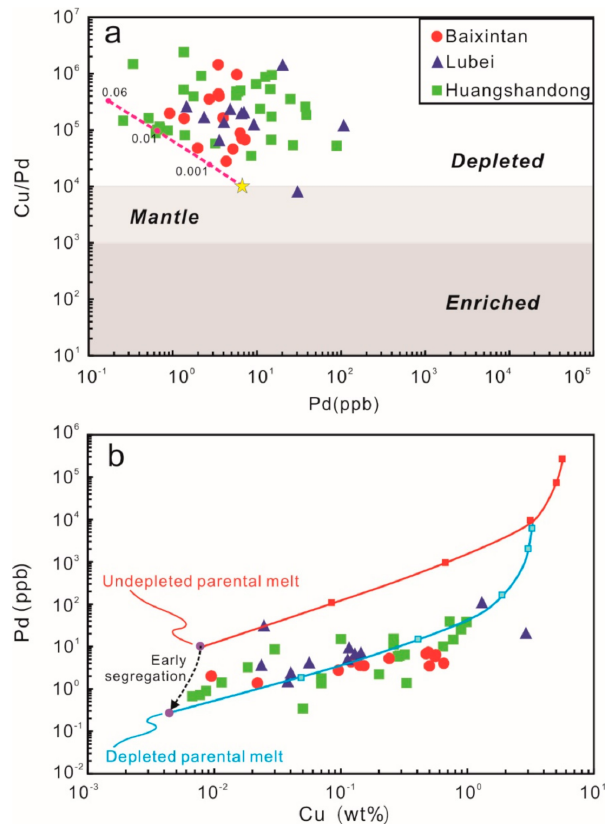
Figure 10. Platinum group element (PGE) contents and ratio sulfide ores in the Baixintan and other magmatic sulfide Ni–Cu deposits in the Northern Tianshan, indicating early segregation and PGE-depleted parental magma (after Barnes et al. [82]): ( a ) plot of Cu / Pd vs. Pd (after Lightfoot et al. [83]). The numbers are sulfide percentages removed from the initial magma system. The yellow star represents the composition of the primitive mantle. ( b ) Pd vs. Cu. Data sources: Baixintan [26,29], Lubei [29], and Huangshandong